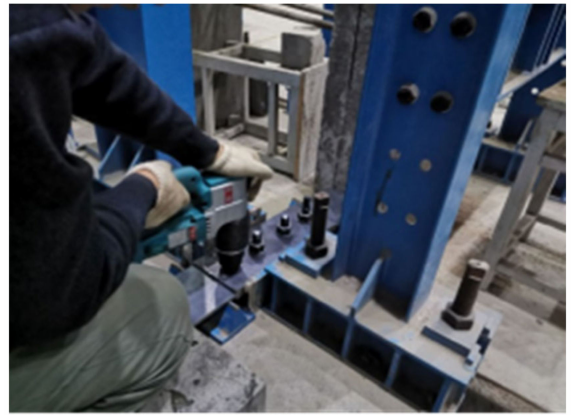
Figure 6. Final twist of high-strength